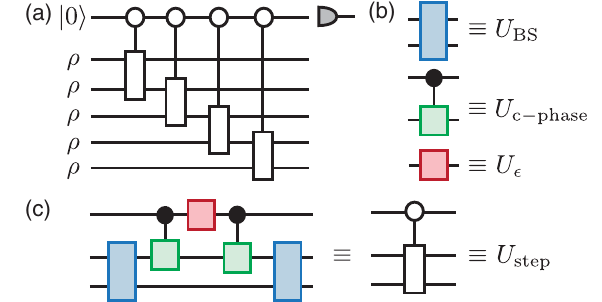
FIG. 1. (a) Circuit representation of the protocol to determine the spectrum of a density operator ρ . It consists of n stroboscopic steps (operations) that each involve an ancilla system and two copies of the state under investigation. (b) Each step can be constructed from three basic operations: tunnel coupling between neighboring copies (blue), a controlled (dispersive) phase shift for atoms in the lattice based on the state of the ancilla system (green), and rotations of the ancilla qubit (red). For a description of these operations, we refer to the main text [Eqs. (4), (5), and (7); see also Fig. 2]. (c) Construction of the stroboscopic step U from these elementary operations. Note that it differs from step SU 0 the one in Eq. (2) by an additional swap, U . This step ¼ step additional swap ensures that all processes involve only neighbor- ing copies (see Appendix